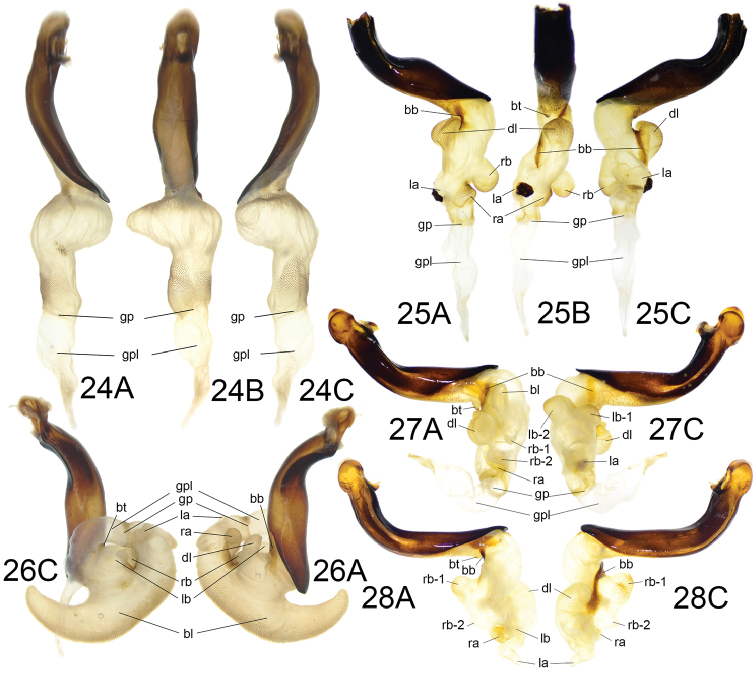
Endophallus of species representatives. A left lateral view B dorsal view C right lateral view 24Trigonotomalewisi Bates from Yunnan (type I) 25Lesticusperniger Roux & Shi from Yunnan (type I) 26Lesticusmagnus (Motschulsky) from Liaoning (type III) 27Lesticusauricollis Tschitschérine from Fujian (type I) 28Lesticusinsignis Gestro from Sabah (type IV).